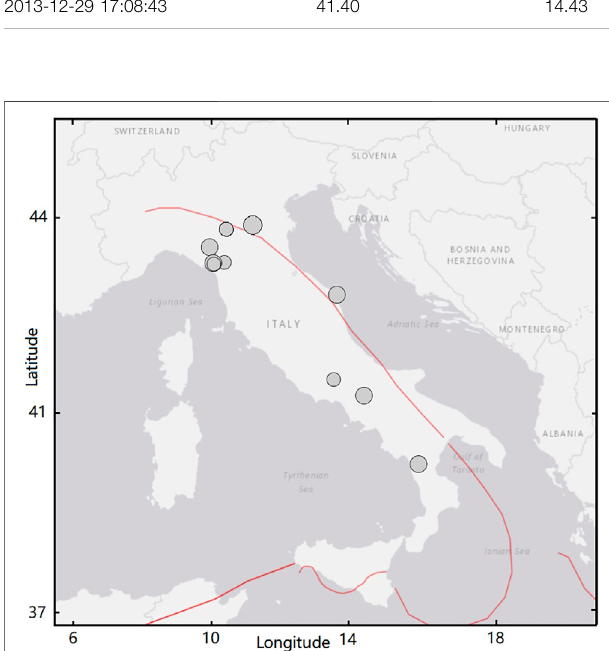
FIGURE 2 | Map of the 10 earthquakes that happened in land of Italy from 2010 to 2013 with M ≥ 4.7. The red line is the main fault systems of Italy.